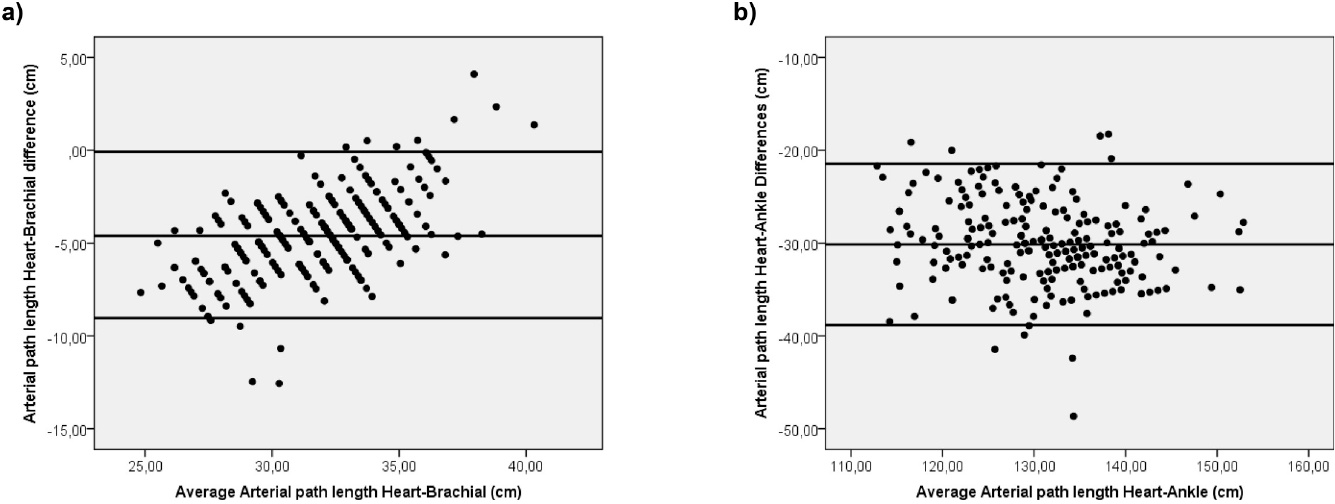
Fig 1. Bland Altman plots for manual measured and automatic estimated arterial path length for heart-brachial (a) and heart-ankle (b).